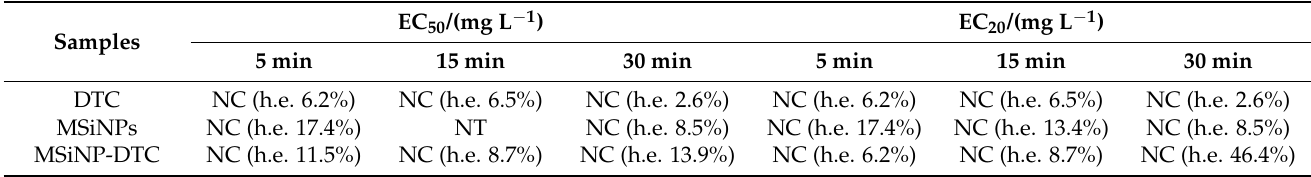
Table 2. A. fischeri toxicity results obtained from bioluminescence test (in mg L − 1 ) after exposure to DTC, MSiNPs, and MSiNP-DTC at 5, 15, and 30 min of exposure (95% confidence interval, inside parentheses). Data are highest effect (%) expressed as bioluminescence inhibition percentages and EC 50 /EC 20